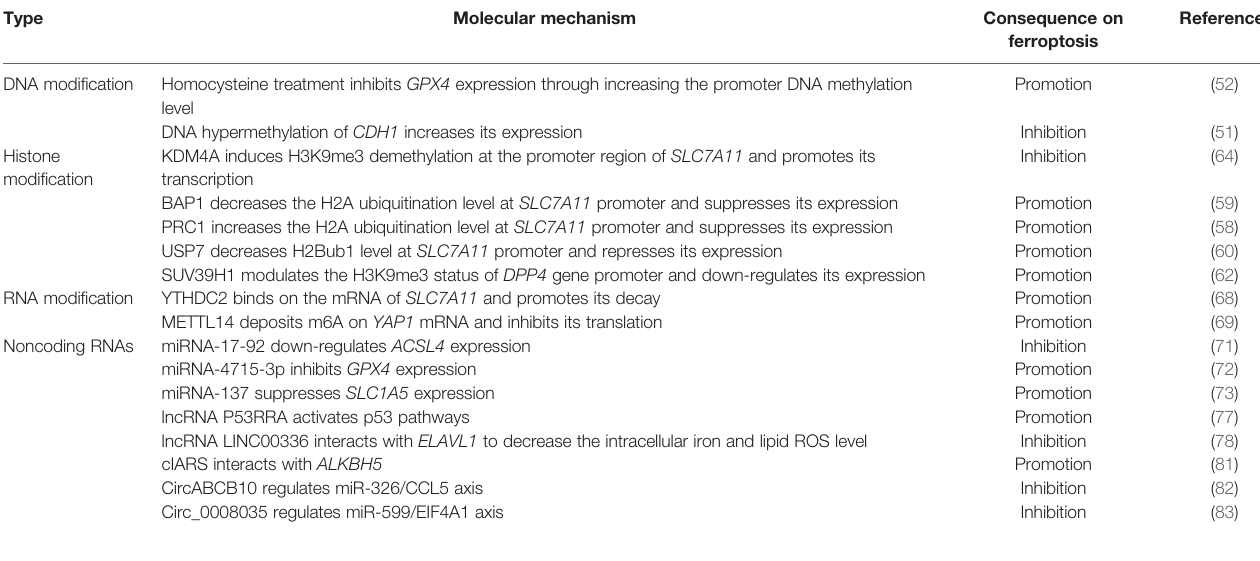
TABLE 1 | Epigenetic regulation of ferroptosis-associated